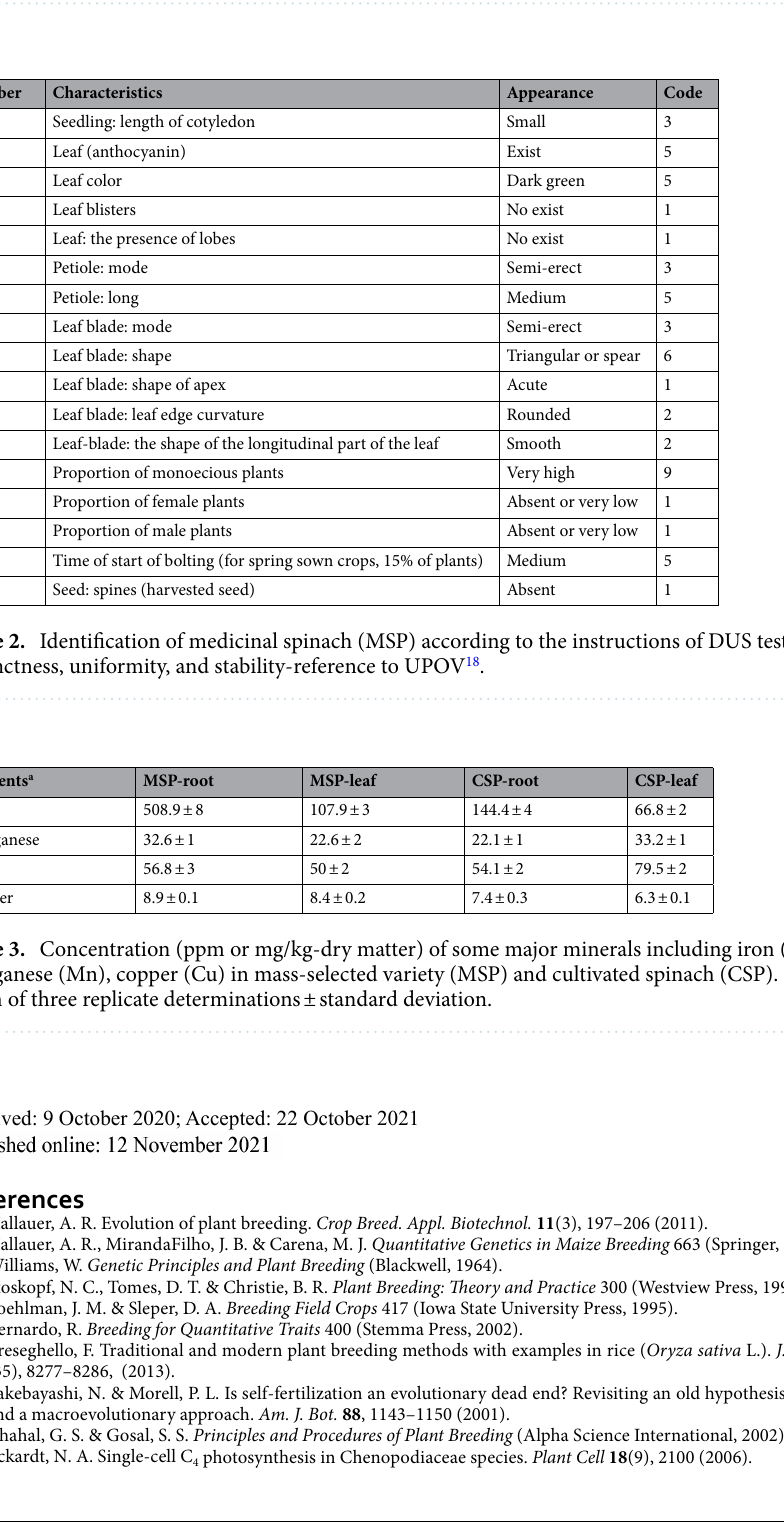
Table 1. Appearance differences and morphological characteristics of cultivated spinach (CSP) and medicinal spinach (MSP).